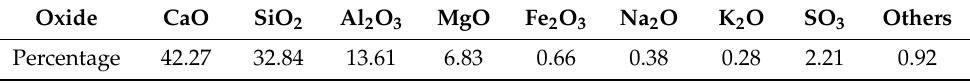
Table 1. Chemical composition of slag